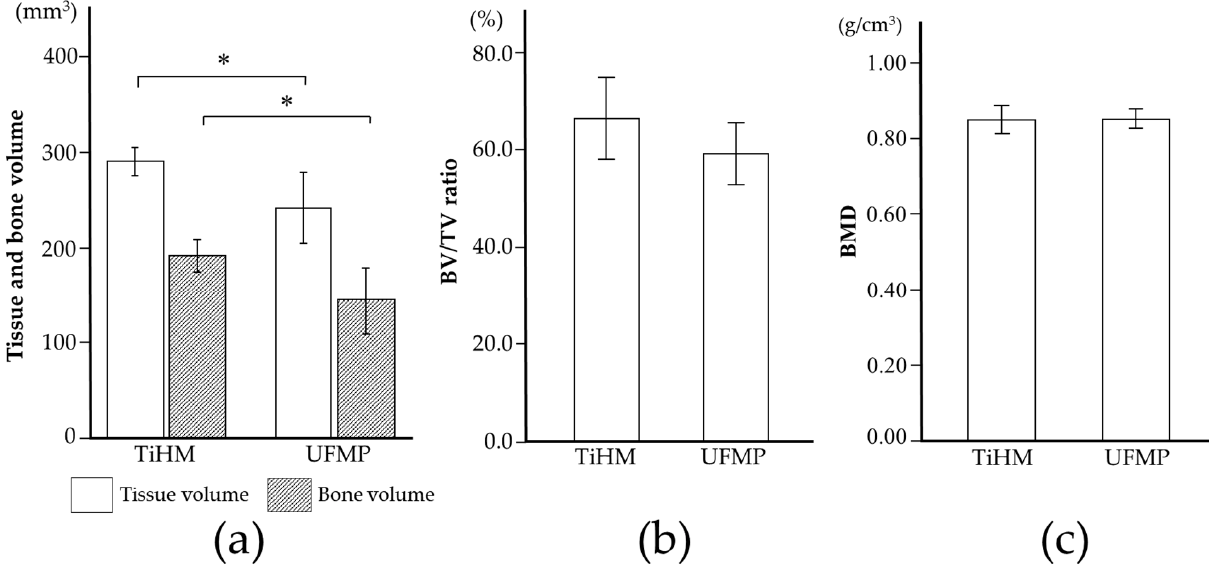
Figure 9. Radiographic analyses ( a ) TV and BV. ( b ) BV/TV ratio. ( c ) BMD. All data are presented as means ± SD; * p < 0.05.